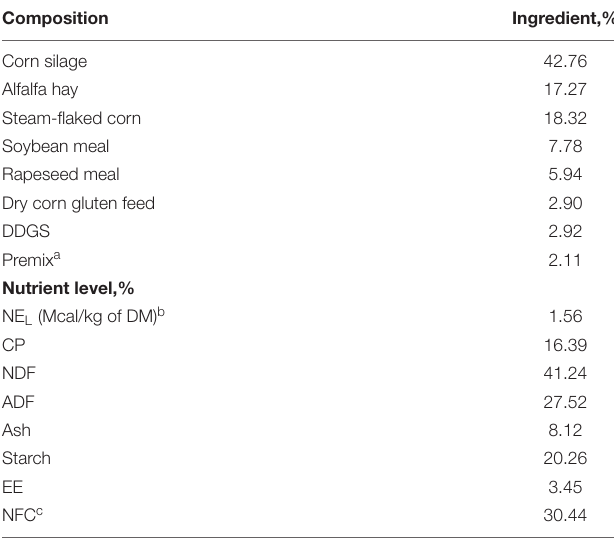
TABLE 1 | Ingredient and nutrient composition of the experimental ration (DM